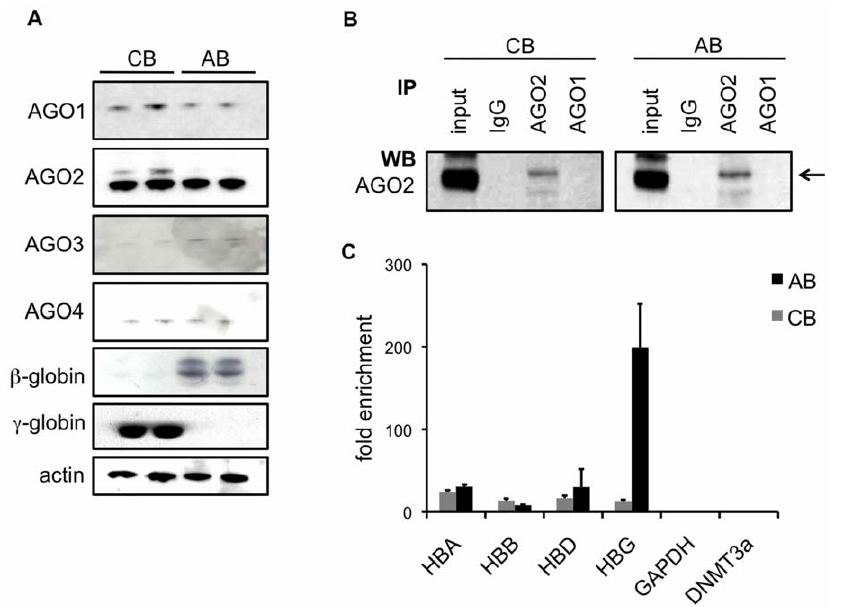
Figure 1. c -globin mRNA is bound by AGO2 in reticulocytes with low HbF content. (A) Western blot analysis of AGO1, 2, 3, 4, c -globin and b -globin in reticulocytes purified from umbilical cord blood ( CB ) and blood from adults ( AB ). Actin was included as loading control. (B) AGO2- containing RNA-protein complexes were immunoprecipitated from equal amounts of cord blood reticulocyte ( CB ) and adult blood reticulocyte ( AB ) lysates using rat monoclonal anti-AGO2 antibodies; as isotype control, non-specific rat immuno-globulin ( IgG ) as well as rat monoclonal anti-AGO1 antibodies were used. Immunoprecipitations were compared to lysate ( input ) and subjected to immunoblot analysis using anti-AGO2 antibodies. (C) The amounts of a -globin ( HBA ), b -globin ( HBB ), c -globin ( HBG ) and d -globin ( HBD ) mRNA immunoprecipitated together with AGO2 from CB and AB were compared to amounts of globin mRNAs that were non-specifically immunoprecipitated with control IgG. As control GAPDH and DNMT3a mRNAs were analyzed. For every sample the same amount of precipitated RNA was analyzed. The values are expressed as fold-enrichment over IgG immunoprecipitations, and represent mean 6 SEM (n=3).